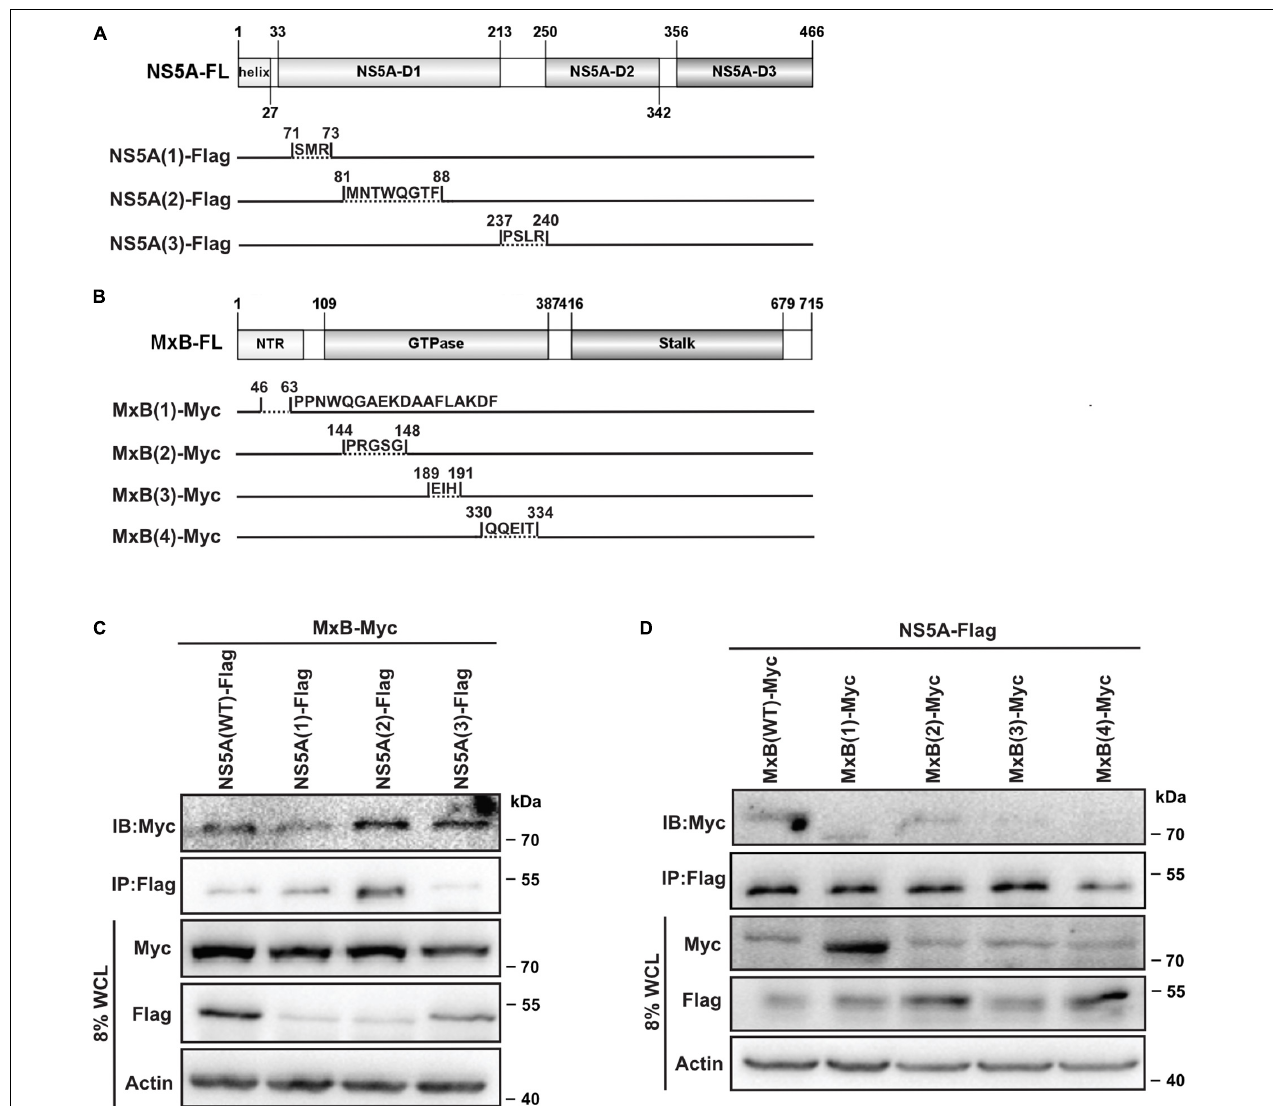
FIGURE 3 | Validation of the predicted MxB–NS5A interaction. (A,B) Schematic representation of NS5A and MxB truncations. Diagrams were constructed using IBS (version 1.0) (Liu et al., 2015). The interactions of MxB with NS5A truncations (C) and those of NS5A with MxB truncations (D) were detected by IP with anti-Flag antibody followed by immunoblotting (IB) with anti-Myc antibody in HEK293T. Data are representative of three independent experiments. MxB, myxovirus resistance B; NS5A, non-structural protein 5A; IP,